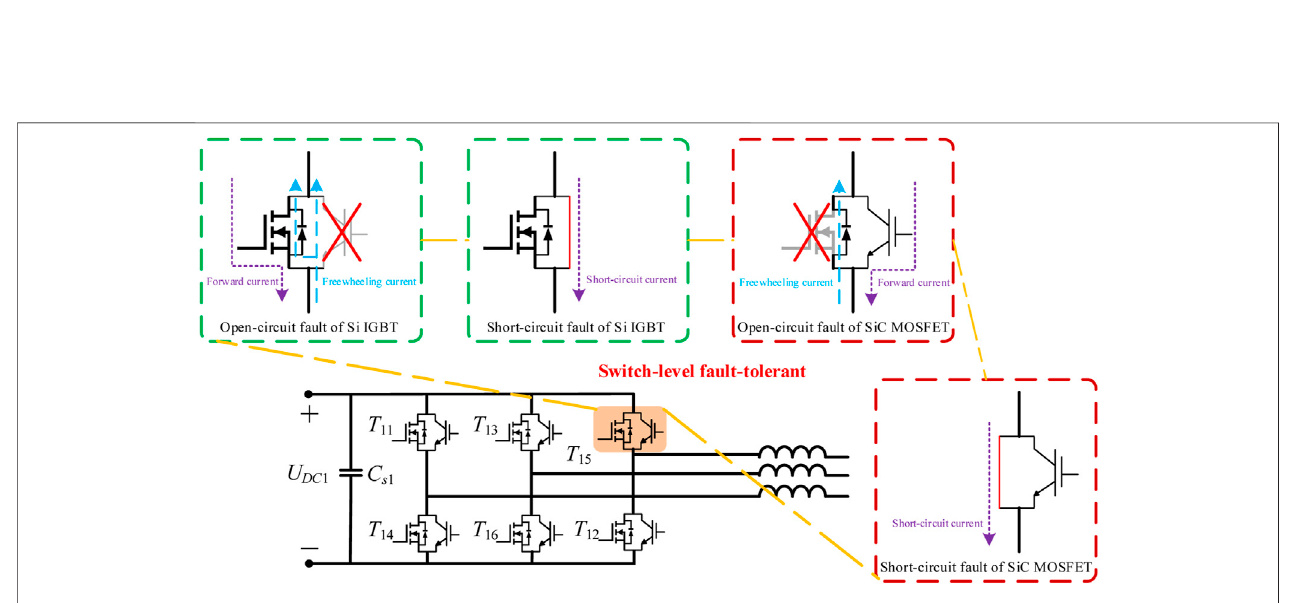
FIGURE 2 | Switch-level fault-tolerant topology.